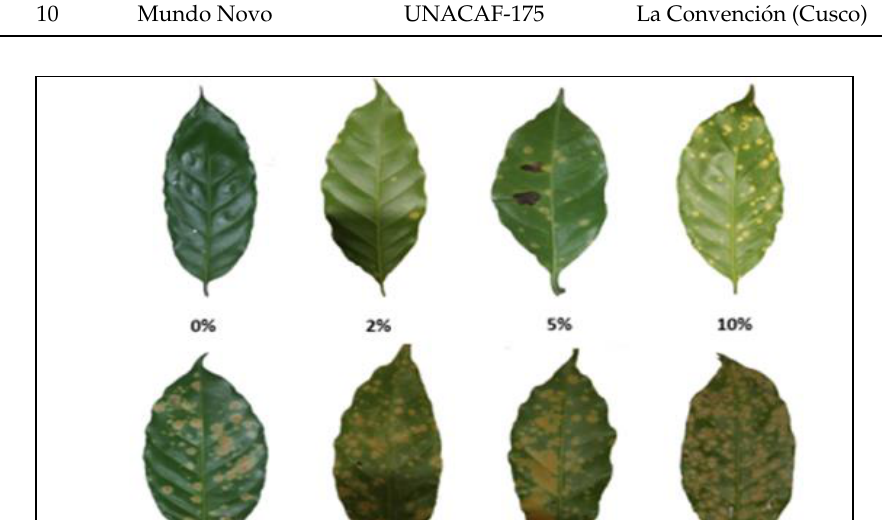
Figure 1. Degrees of severity of coffee leaf rust used in this experiment [7].